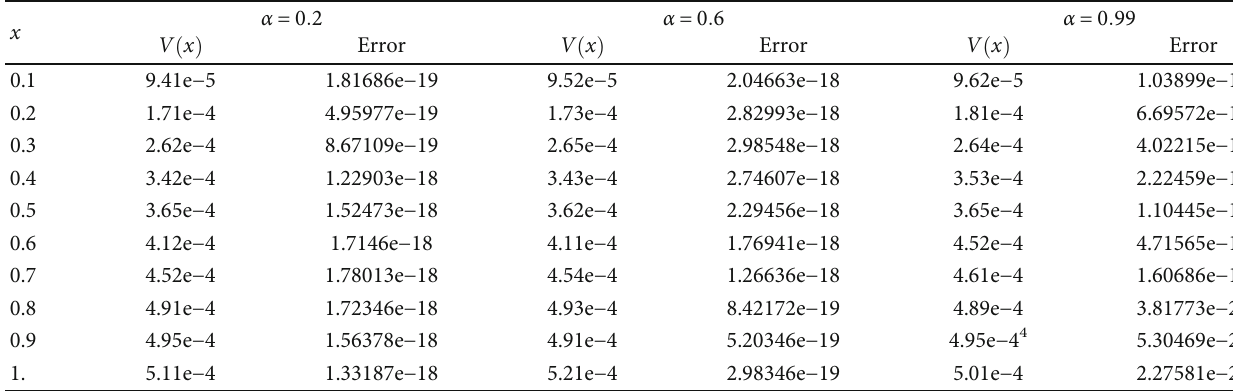
= 0 : 001 are fi xed. p